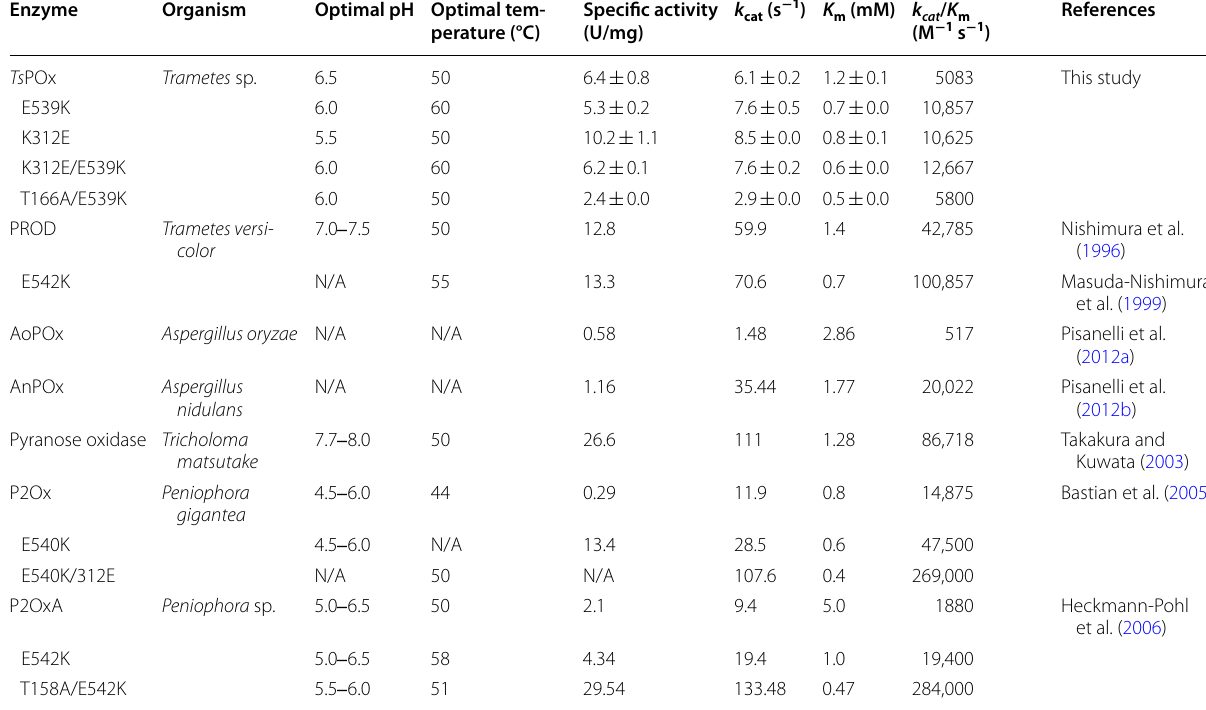
Table 1 Biochemical properties of Ts POx, its mutants, and other pyranose oxidases Enzyme Organism